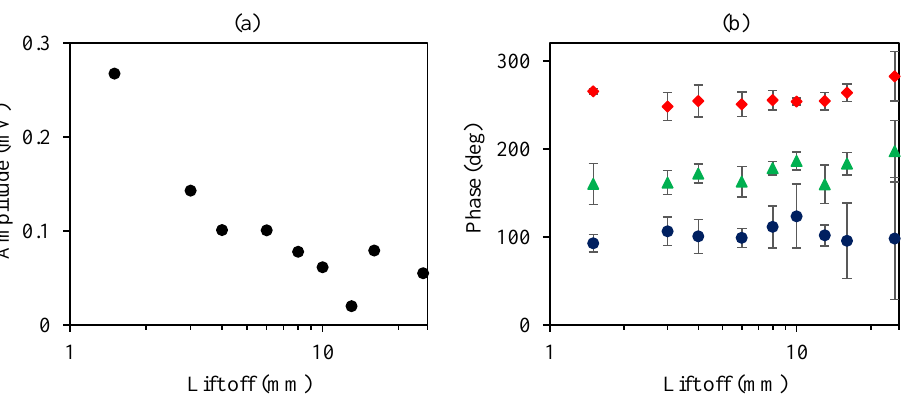
Figure 7. Amplitude ( a ) and phase ( b ) rf signal extracted from Figure 7 as a function of lift-off. The measurement was performed at operating frequency of 29kHz. The red diamonds, green triangles and blue circles represent the data recorded over the vortex radii with coordinates (41, 50)mm to (41, 70)mm, (50, 41)mm to (70, 41)mm, and (41, 40)mm to (41, 20)mm,